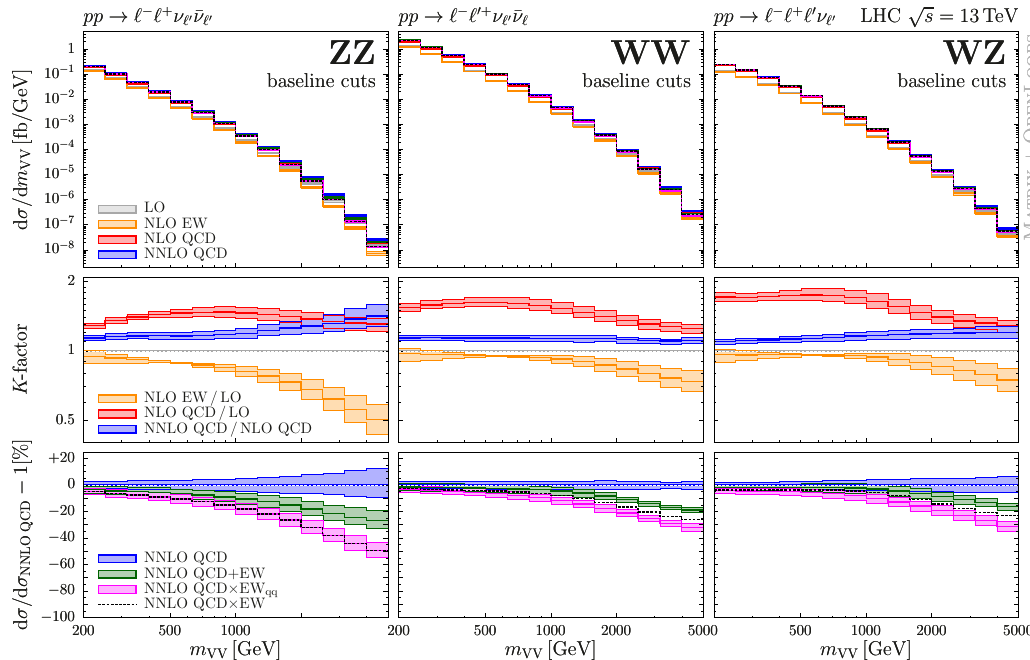
Figure 7 . Distribution in the invariant mass of the reconstructed diboson system for the pro- cesses (3.1){(3.3) at 13 TeV. Baseline cuts are applied without jet veto. Plot format and predictions as in (cid:12)gure